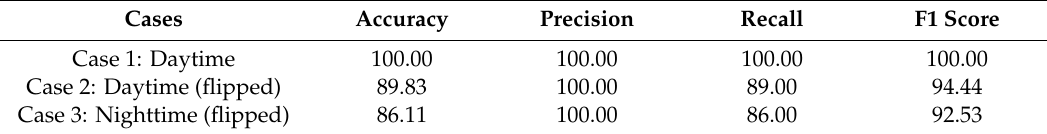
Table 3. Performance measurement in (%).